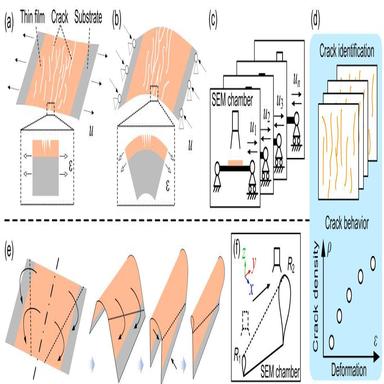
Schematic illustration of characterization of crack behavior in response to deformation. a) Uniaxially stretching and b) bending can generate a tensile strain on the upper film, thus inducing the cracking. c) In-situ test in a SEM chamber. By applying a series of displacements, u, different strains can be applied on the upper film. d) Identification of crack features (crack density, ρ) corresponding to deformation (applied strain, ε) leads to quantitative results of crack behavior (ρ vs. ε data). e) Propose